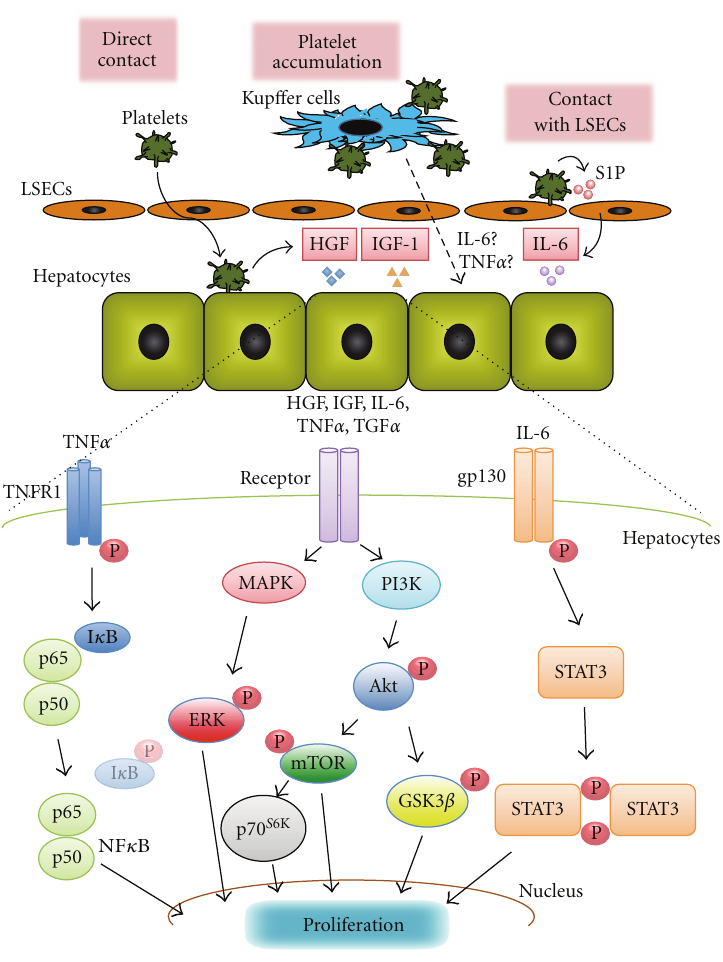
Figure 1: The Roles of Platelets and the Signal Transductions Identified as the Major Cascades in Hepatocyte Proliferation. After liver injury, Kup ff er cells can play a crucial role in the accumulation of platelets in the liver sinusoids and the production of cytokines, such as, interleukin-6 (IL-6) and tumor necrosis factor alpha (TNF α ). Moreover, Kup ff er cells induce the translocation of platelets into the space of Disse and the direct contact between platelets and hepatocytes, which trigger the release of growth factors, such as, hepatocyte growth factor (HGF) and insulin-like growth factor (IGF)-1, which are necessary for hepatocyte proliferation. Platelets also have direct contact with liver sinusoidal endothelial cells (LSECs), which trigger the release of sphingosine 1-phosphate (S1P). S1P induces the secretion of IL-6 from LSECs, which promotes hepatocyte proliferation. During hepatocyte proliferation, IL-6 binding induces both the dimerization and the phosphorylation of gp130 and promotes the docking site of signal transducer and activator of transcription 3 (STAT3). STAT3 is then phosphorylated and translocated to the nucleus. Phosphatidyl inositol 3-kinase (PI3K)/Akt signaling pathway is essential for the platelet-induced hepatocyte proliferation and is activated via the receptor tyrosine kinases through the stimulation of HGF, IGF, IL-6, and many other signaling molecules. Phosphorylated Akt activates glycogen synthase kinase 3 β (GSK3 β ), which induces DNA synthesis and cellular mitosis in hepatocytes. Other downstream Akt factors including mTOR and p70 S6K also play critical roles in regulating the growth of hepatocytes. Mitogen-activated protein kinase (MAPK)/extracellular signal-regulated protein kinase (ERK) signaling pathway is also immediately activated after hepatectomy and thereafter phosphorylated ERK translocates to the nucleus. TNF α /nuclear factor κ B (NF κ B) signaling pathway is activated via the TNF receptor 1 (TNFR1). NF κ B is a heterodimer composed of two subunits, p65 and p50, with inactivated by inhibitor of NF κ B (I κ B). After stimulation with TNF α , NF κ B is activated by the removal of I κ B from its p65 subunit, followed by the migration to the cell